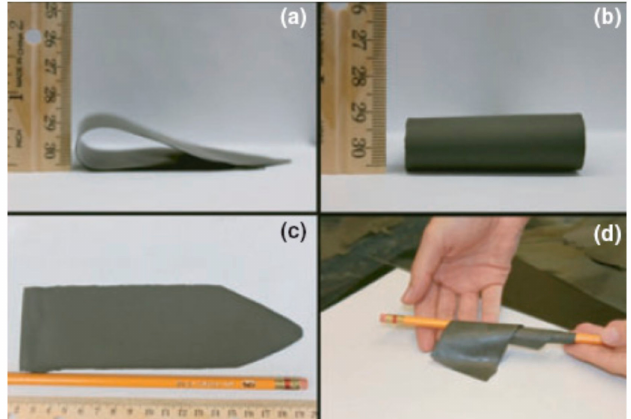
Figure 5. ZrB 2 green tapes: ( a ) side view bend, ( b ) front view bend, ( c ) top view, and ( d ) wrapped around a pencil as a demonstration of the tape’s flexibility. Reproduced with permission from [50].